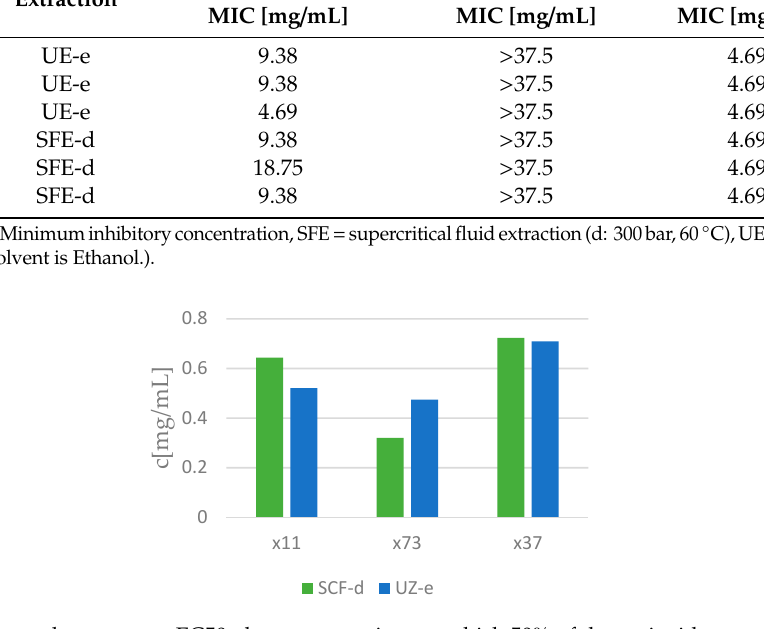
Figure 6. The graph represents EC50, the concentrations at which 50% of the antioxidant activity of the selected extract was measured.